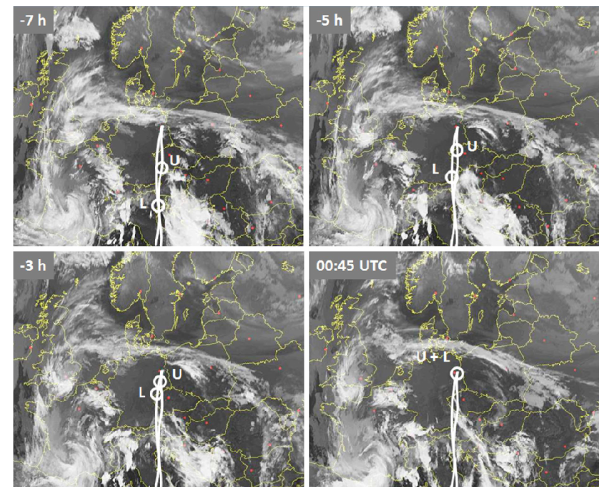
Fig. A1. Cloud images from the Meteosat satellite at four different Figure A1. Cloud images from the Meteosat satellite at four different times (Eumetsat, 2012). 3 times (Eumetsat, 2012). White lines: projections of the trajectories White lines: projections of the trajectories ending in the upper ‘U’ and lower ‘L’ cloud at 0:45 4 ending in the upper “U” and lower “L” cloud at 00:45UTC. White UTC. White circles: respective positions of air parcels 7 h, 5 h and 3 h upstream. 5 circles: respective positions of air parcels 7h, 5h and 3h upstream.